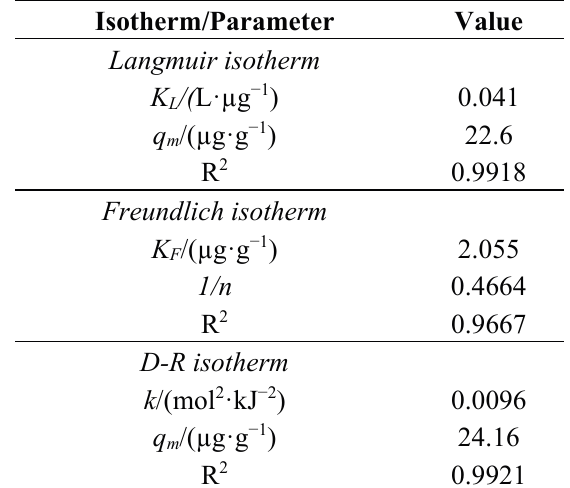
Table 2. Parameters of Freundlich, Langmuir and D-R isotherms for As(V) adsorption onto Fe-XAD8-DEHPA